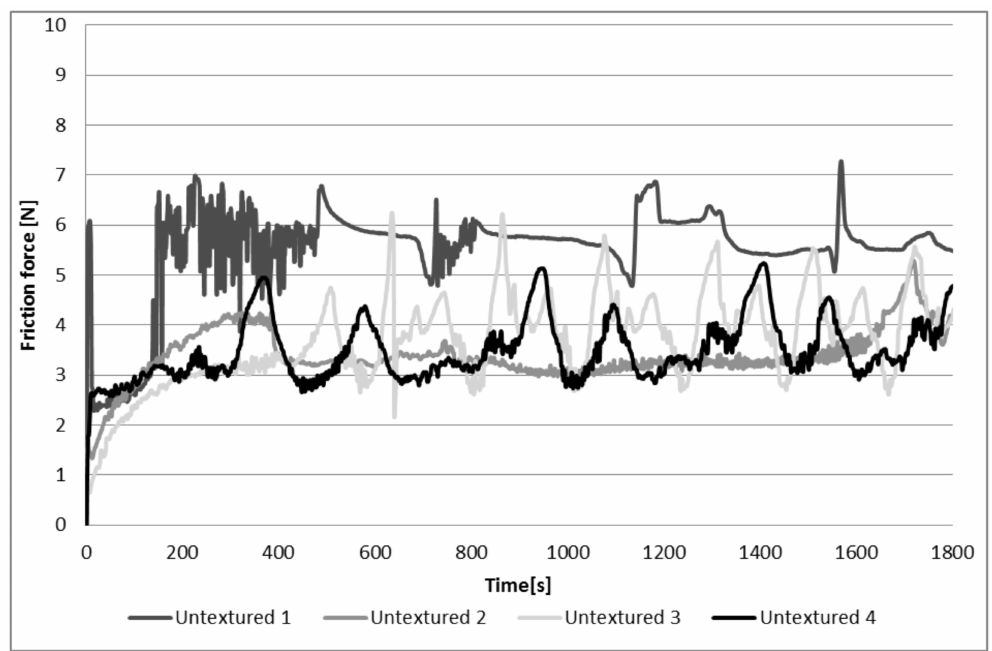
Figure 7. Friction force versus time for assembly with an untextured disc. Figure 8 presents friction force runs for assemblies with textured disc of type 1.